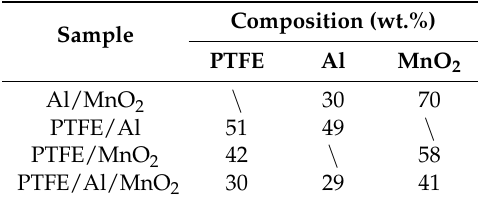
Table 1. Formulation of four experimental